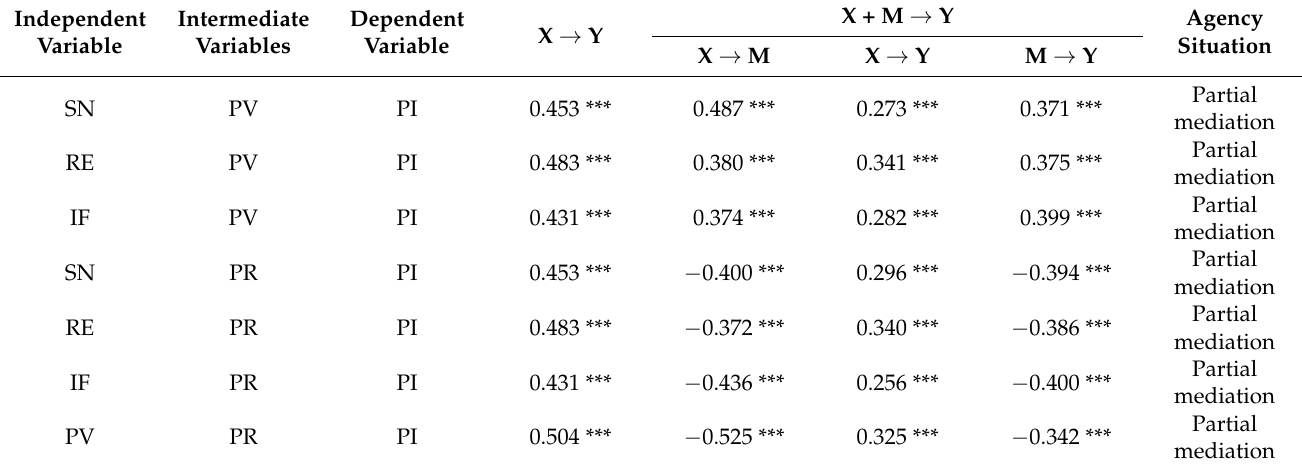
Table 8. Mediating effect test of PV and